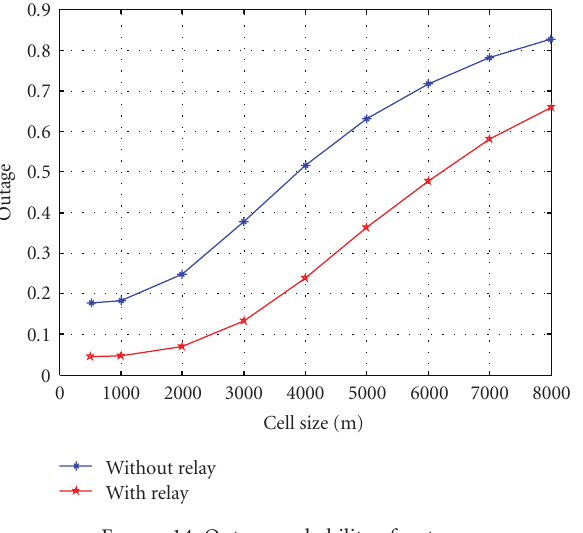
Figure 16: Half duplex versus direct link.